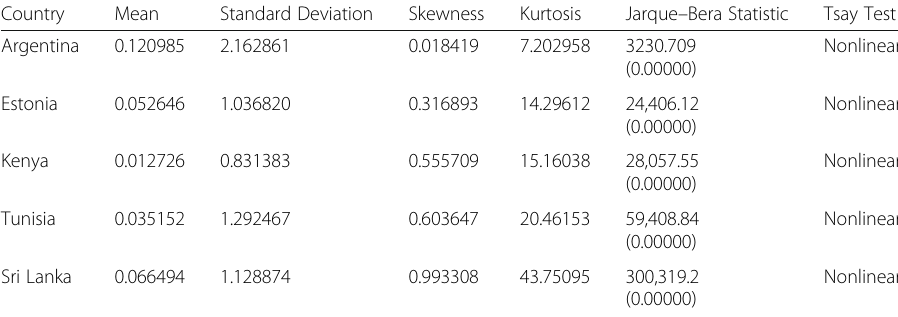
Table 3 Descriptive Statistics for Frontier Markets Country